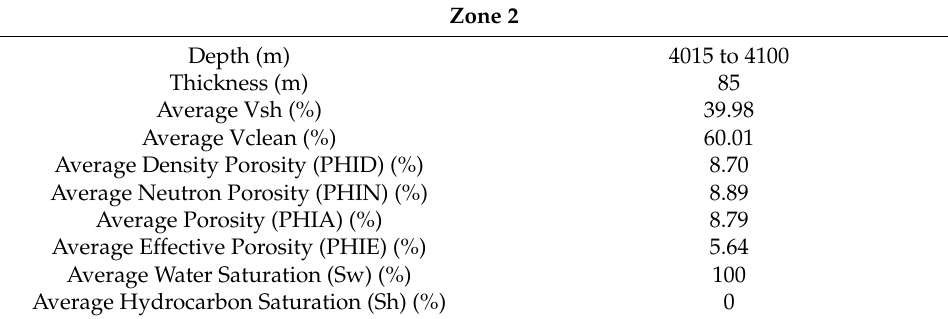
Table 8. Petrophysical interpretation of reservoir zone